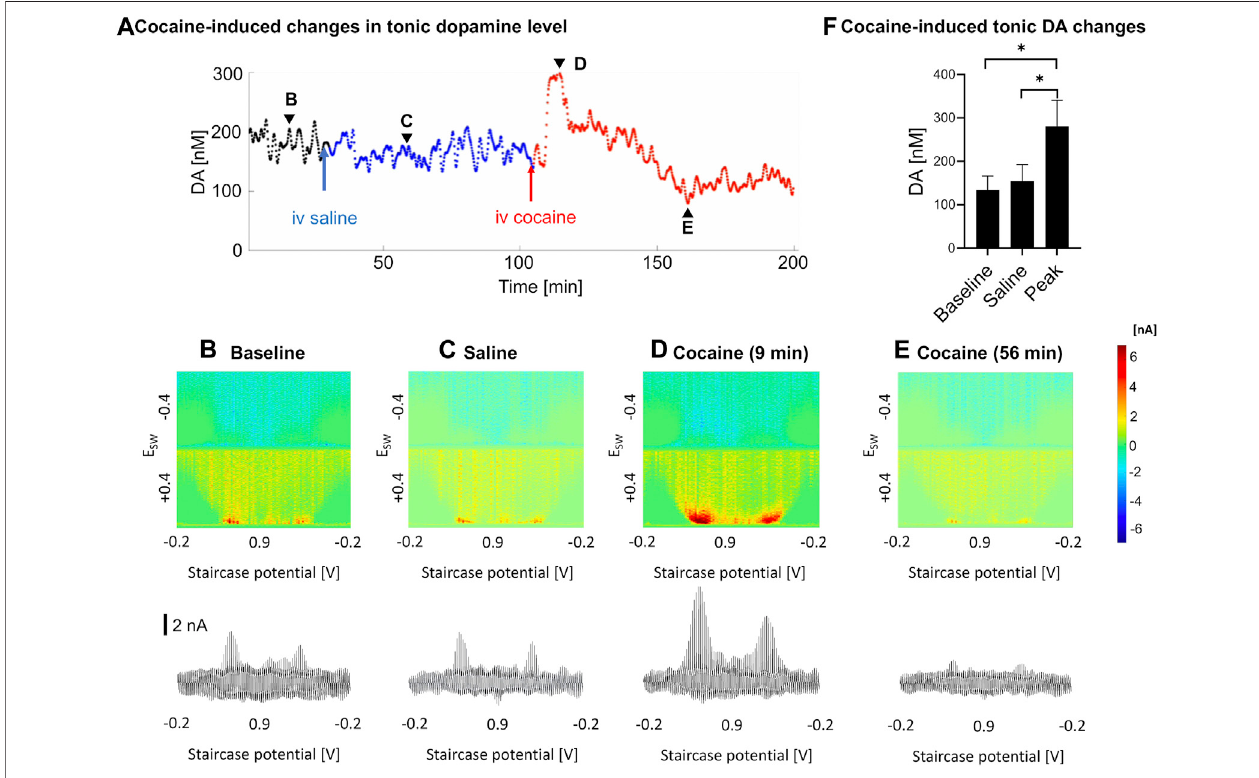
FIGURE 3 | An example of tonic dopamine measurements obtained from the nucleus accumbens core in a single rat with saline then cocaine i.v. injections. (A) . Changes in tonic dopamine concentration over time, where the black line denotes the stabilization period, blue line denotes control (saline) and red line denotes post- cocaine measurements. (B – E) . High-dimension color plots and voltammograms pre- and post-injections, corresponding to the time points (arrowheads) in (A) , respectively, (F) Comparison of tonic dopamine concentrations pre- and post-(peak) injection. Ratio two-tailed paired t- test, p (cid:1) 0.002, n (cid:1) 5 rats. See supplementary information for a video of the experiment. DA ,